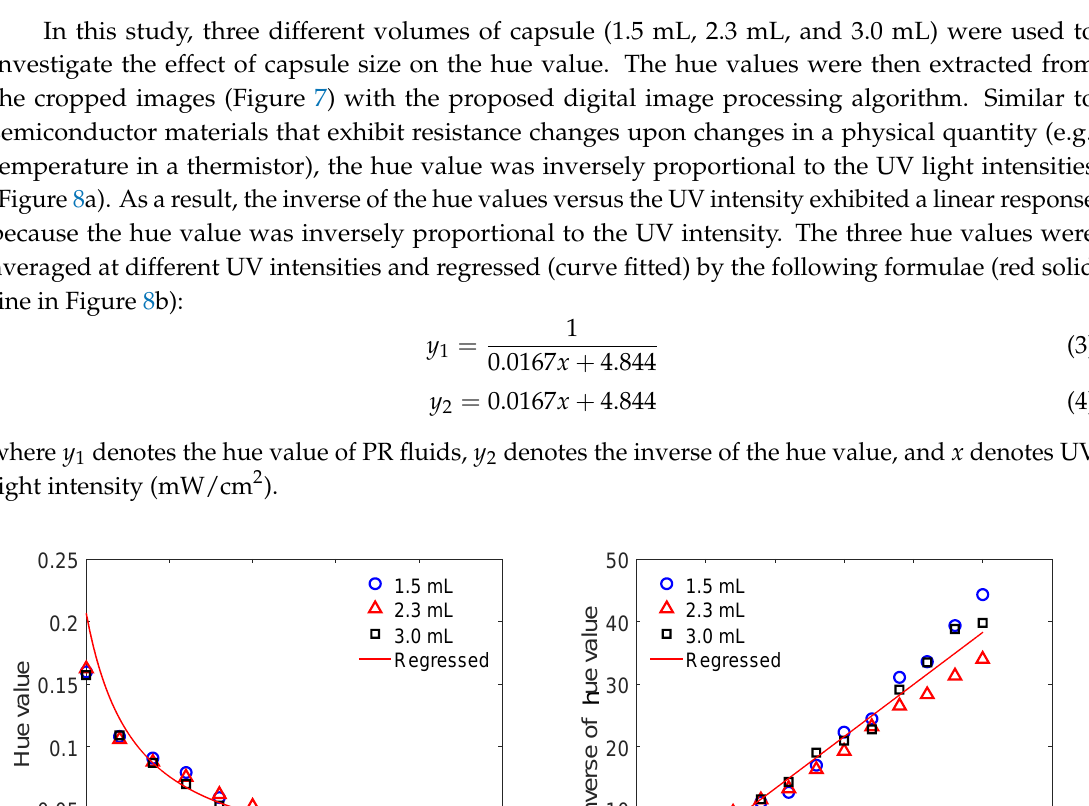
Figure 7. Cropped images from original colorimetric responses for digital image processing.